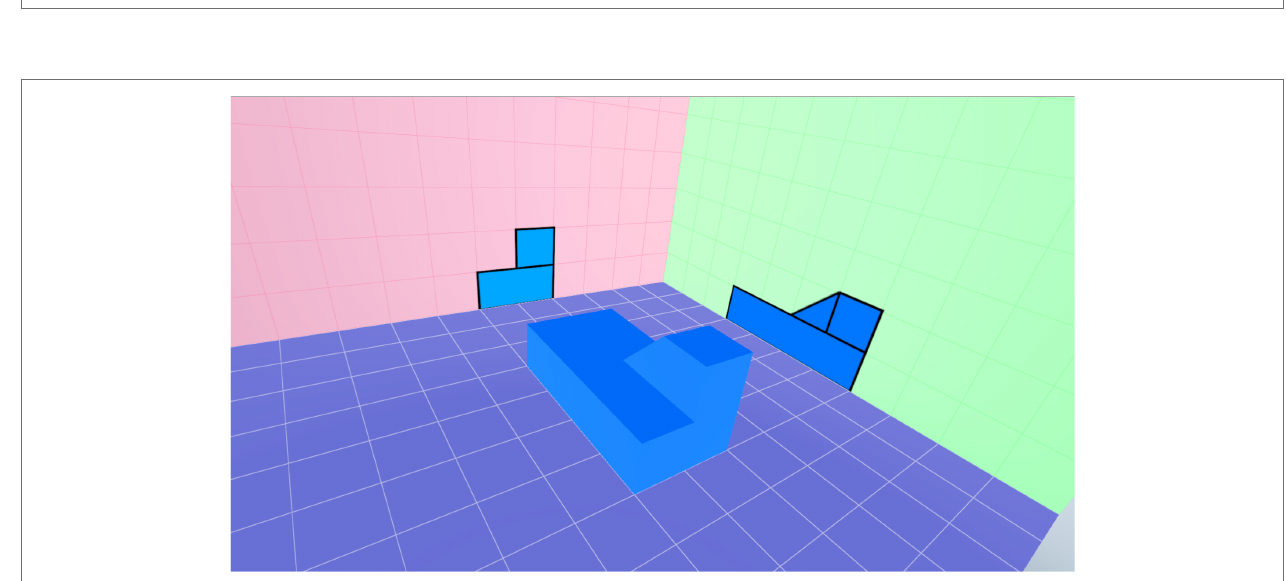
FIGURE 4 | An exemplary screenshot of the second level of spatial